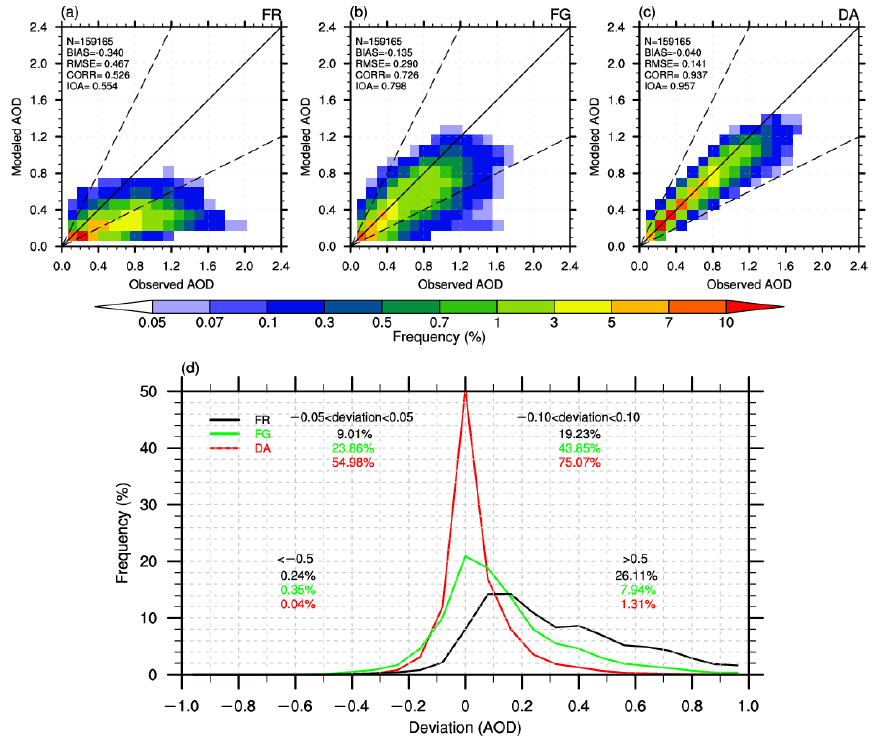
Figure 5. Probability density distribution of the assimilated Himawari ‐ 8 AODs versus the simulated AODs in the ( a ) FR experiment, ( b ) first guess, and ( c ) analyses in DA experiment, calculated at daily 06:00 UTC from 8 to 22 March 2021. The continuous black line is the 1:1 line, and the dashed black lines correspond to the 1:2 and 2:1 lines. N shows number of data used. ( d ) Frequency distributions of deviations (modeled AODs minus Himawari ‐ 8 observed ones). The percentages of deviations between ±0.05, ±0.1, < − 0.5, and >0.5 are also shown.